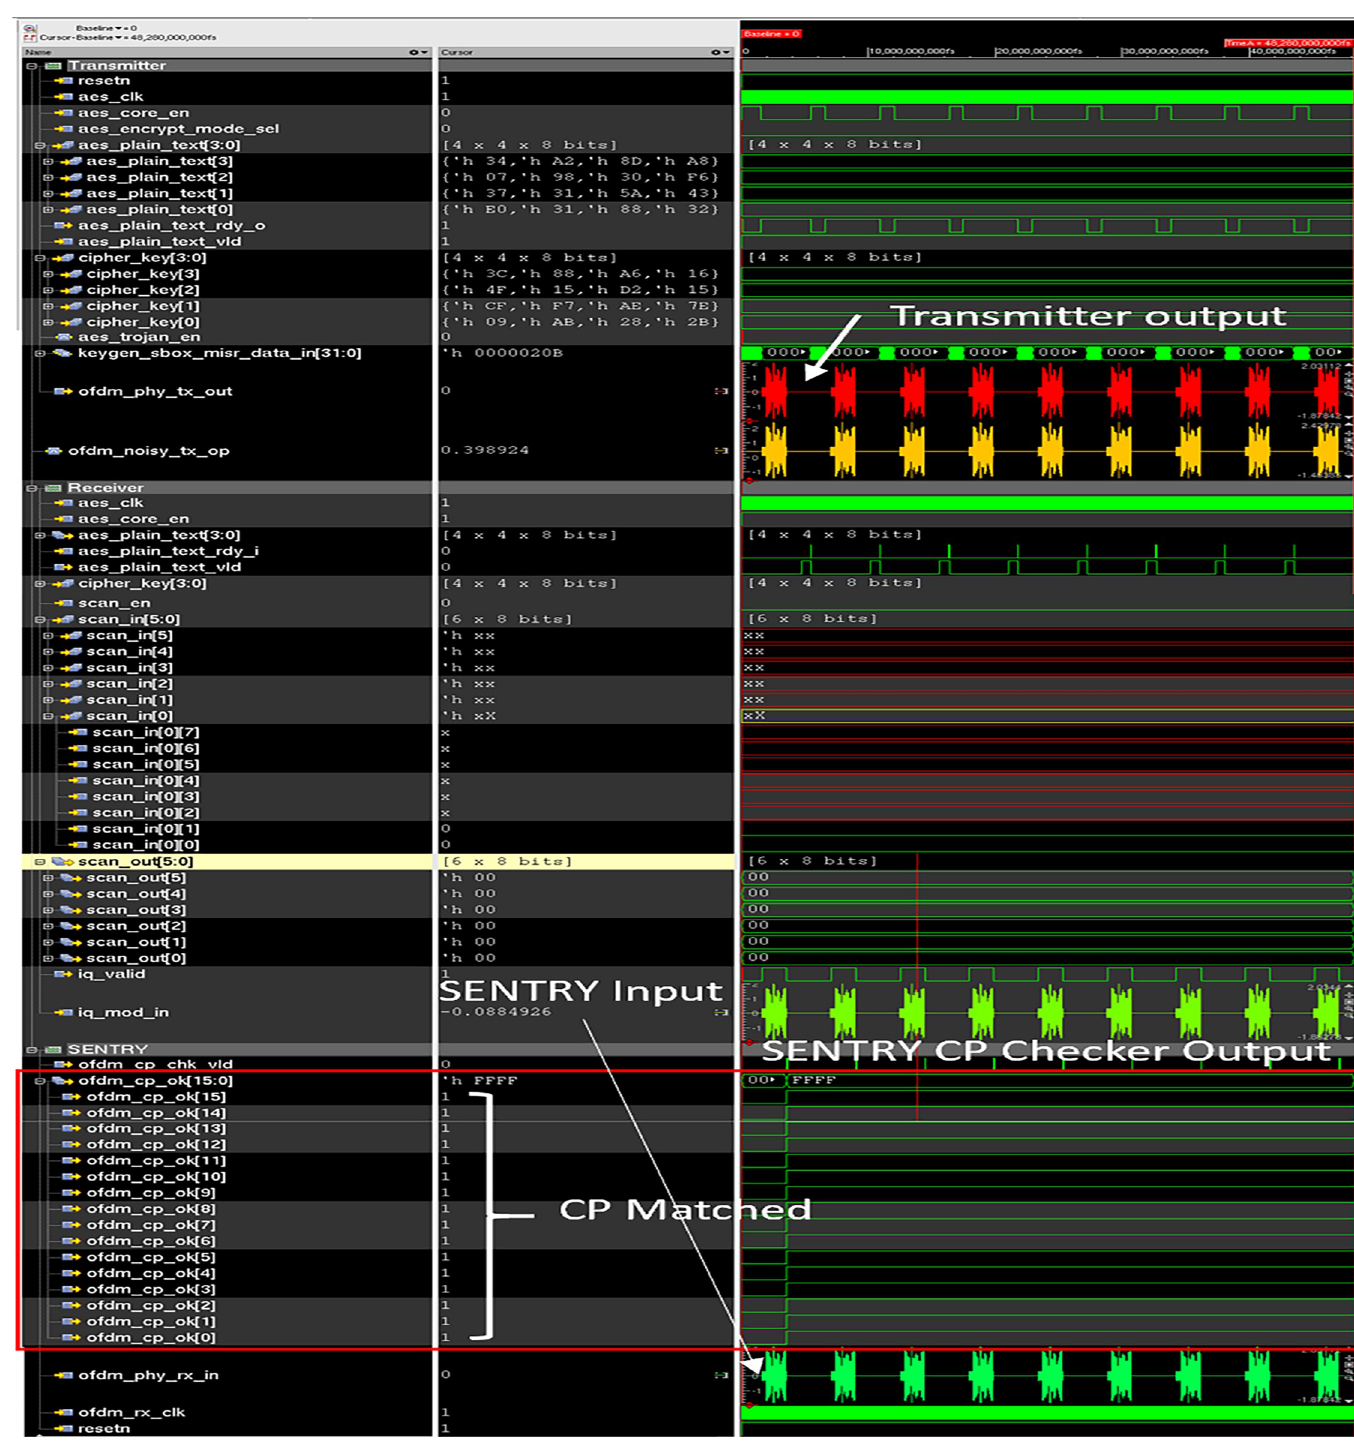
Fig 18. Simulation waveform of SENTRY with trojan free wireless cryptographic IC.